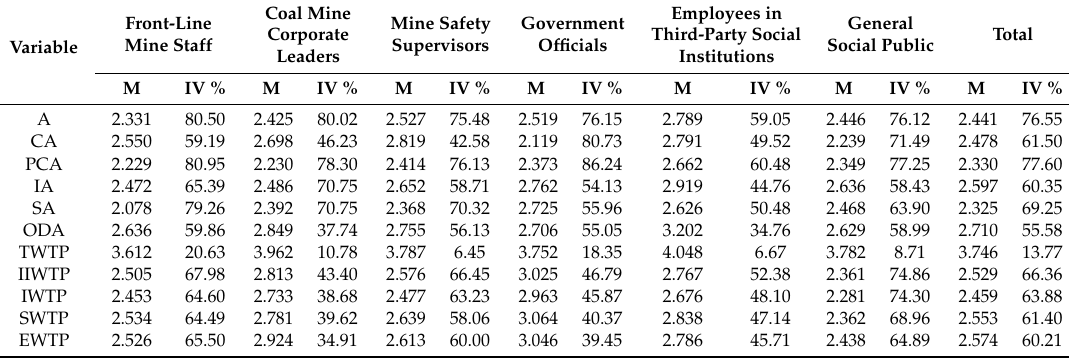
Table 5. Occupational safety and health attention and WTP mean value distribution table of different subjects. Coal Mine Front-Line Corporate Mine Staff Variable